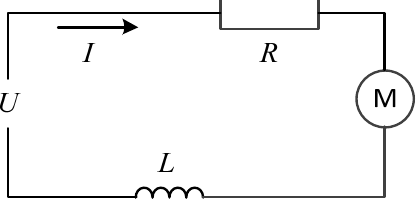
Figure 6. Control circuit diagram of multi-link active suspension.